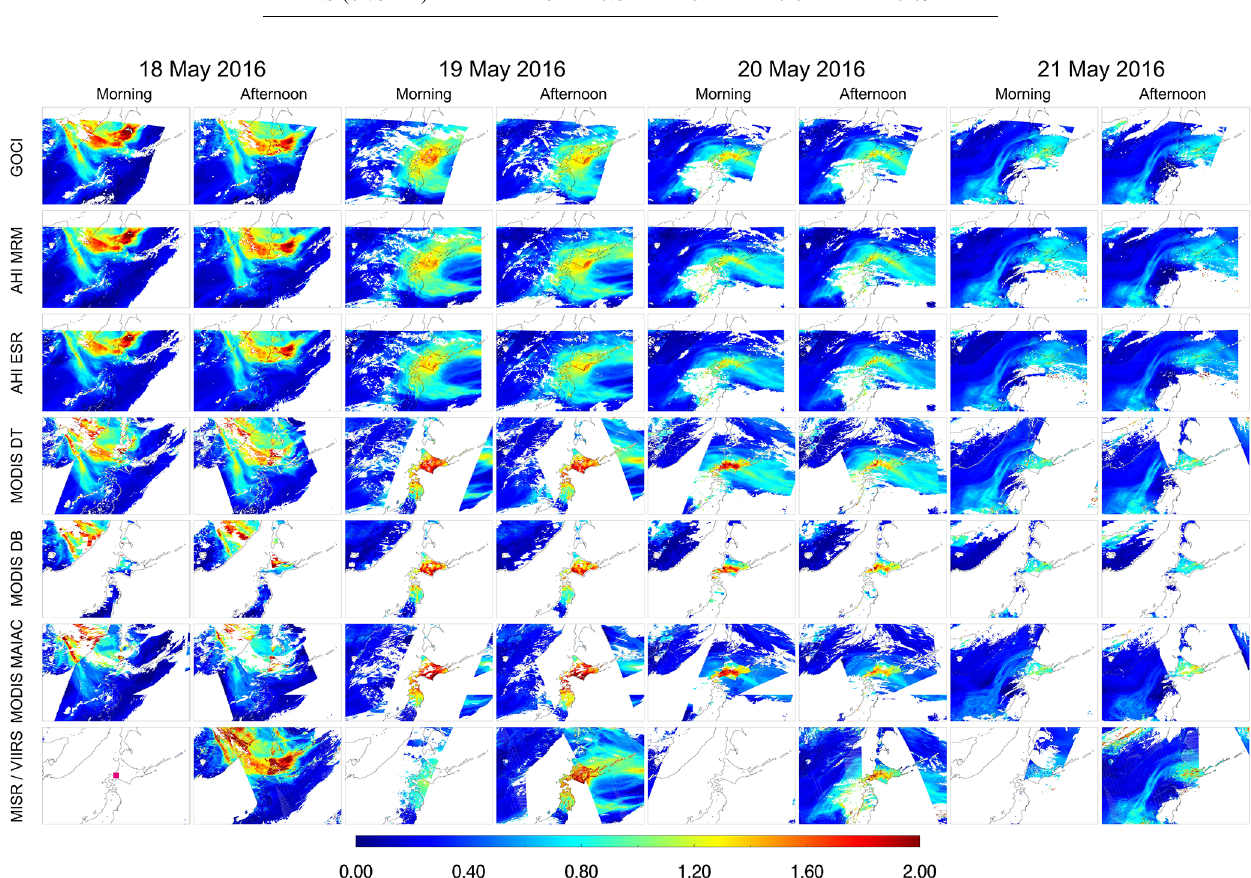
Figure 4. AOD distributions from GOCI, AHI MRM, AHI ESR, MODIS DT03K, MODIS DB, MODIS MAIAC, MISR, and VIIRS over the Hokkaido region during 18–21 May 2016. Note that morning and afternoon AODs for GOCI and AHI refer to 10:30 and 13:30LT, respectively, and for MODIS these refer to the Terra and Aqua measurements, respectively. MISR only has a morning measurement and VIIRS only has an afternoon measurement. The pink symbol in a bottom-left panel shows the location of the Hokkaido University AERONET